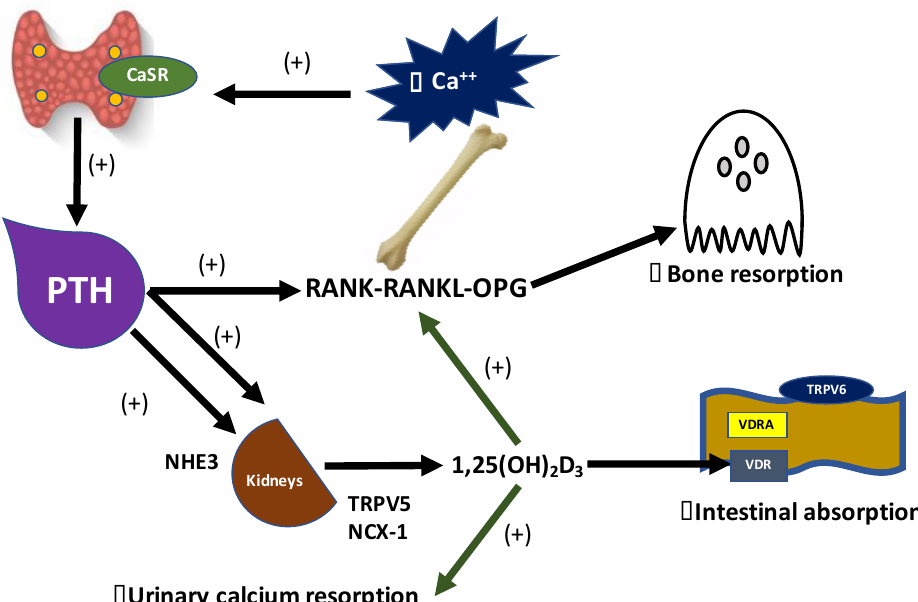
Figure 1. Vitamin D and Parathyroid hormone (PTH) PTH-mediated calcium absorption in intestine, kidneys and bones. CaSRs in the parathyroid glands detect lower levels of blood ionized calcium, leading to the synthesis and secretion of PTH, which in turn promotes the conversion of 25(OH)D to 1,25(OH) 2 D 3 by stimulating 1-alpha-hydroxylase in proximal tubules. 1,25(OH) 2 D 3 is the active form of vitamin D 3 that acts increasing the expression of TRPV6 in the apical membrane of enterocytes, via 1,25(OH) 2 D 3 -VDR complex, thus leading to the intestinal absorption of calcium. The 1,25(OH) 2 D 3 -VDR complex increases the urinary calcium resorption from distal nephron through the luminal insertion of TRPV5, and NCX-1 in the basolateral cellular membrane. PTH directly promotes the urinary calcium resorption by stimulates NHE3 in proximal tubules. PTH and 1,25(OH) 2 D 3 upregulate the RANKL and inhibit OPG, then increasing calcium resorption from